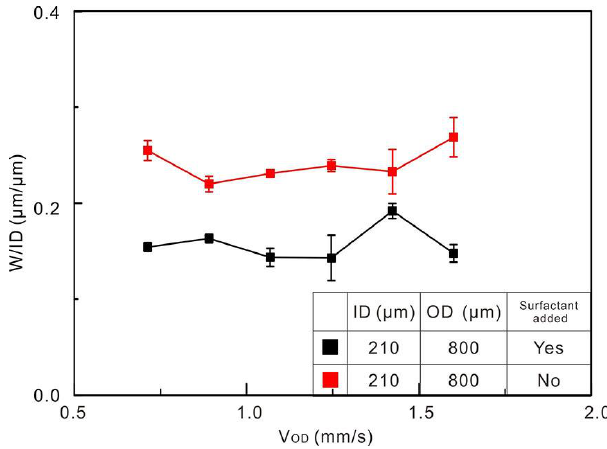
Figure 9. Trace widths normalized by ID as a function of outer channel flow speed with and without surfactant added outer flow (Q ID = 8 μL/min, V P = 40 mm/s).